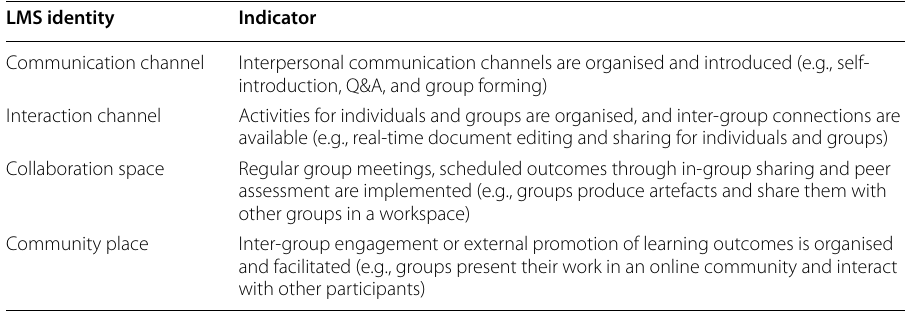
Table 4 Evaluation indicators of LMS identity changes LMS